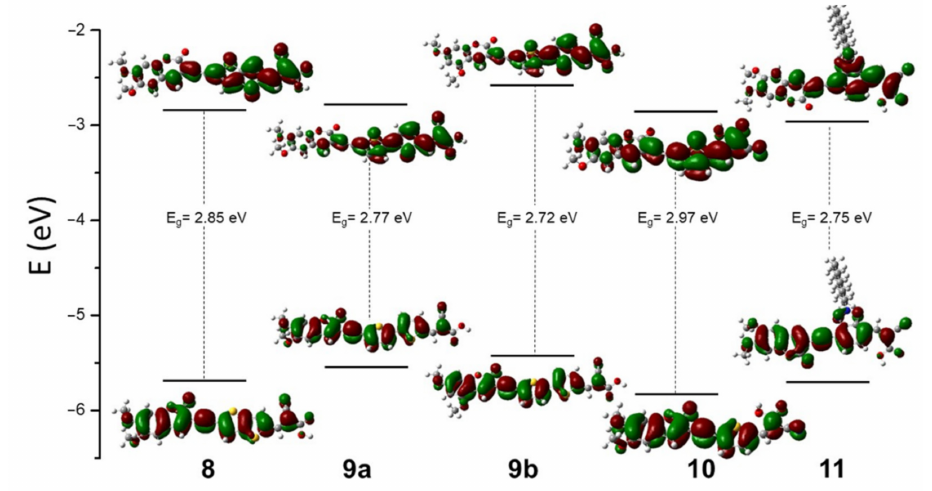
Figure 3. DFT//CAM-B3LYP/6311G(d,p) optimized ground-state geometry together with the frontier molecular orbital energy levels and the relevant electronic density contours (calculated at B3LYP/6311G(d,p) level) for the investigated compounds. Additionally, displayed are the predicted optical band gap energy values, E g .